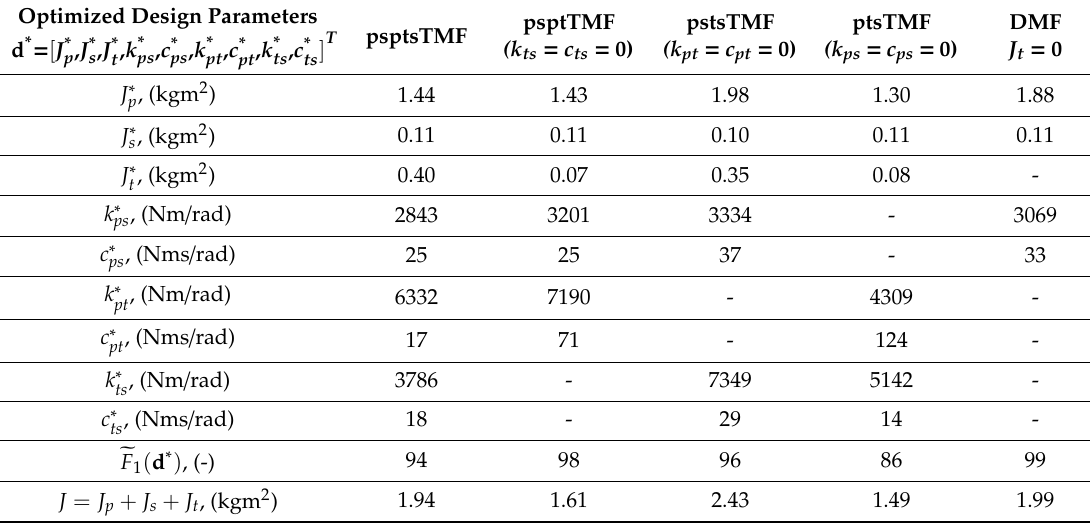
Table 2. Results of the solution of problem WV-PO, T m = 3000 Nm, a e = 3000 Nm. Optimized Design